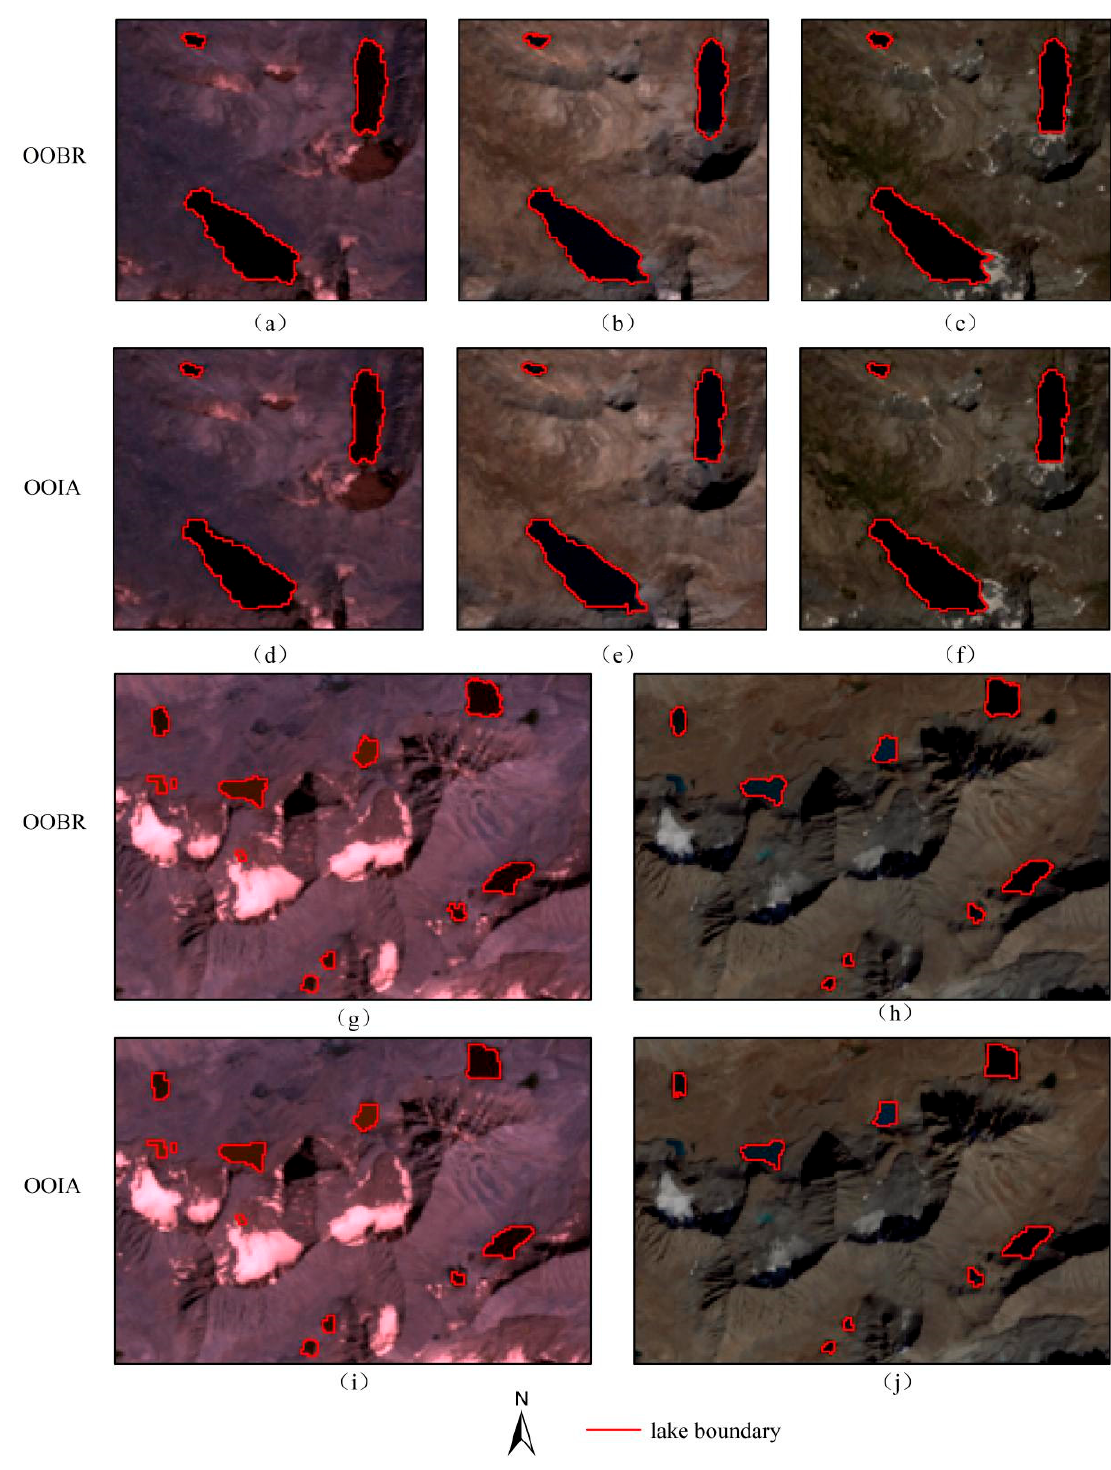
Figure 12. Extraction results with OOIA and OOBR: ( a – c ) are the results of Landsat TM, ETM+ and OLI images, respectively, in study area 1 by proposed method (OOBR); ( d – f ) are the results of Landsat TM, ETM+ and OLI images, respectively, in study area 1 by object-oriented method (OOIA); ( g , h ) are the results of Landsat TM and OLI images, respectively, in study area 2 by proposed method (OOSR); ( i , j ) are the results of Landsat TM and OLI images, respectively, in study area 2 by object-oriented method